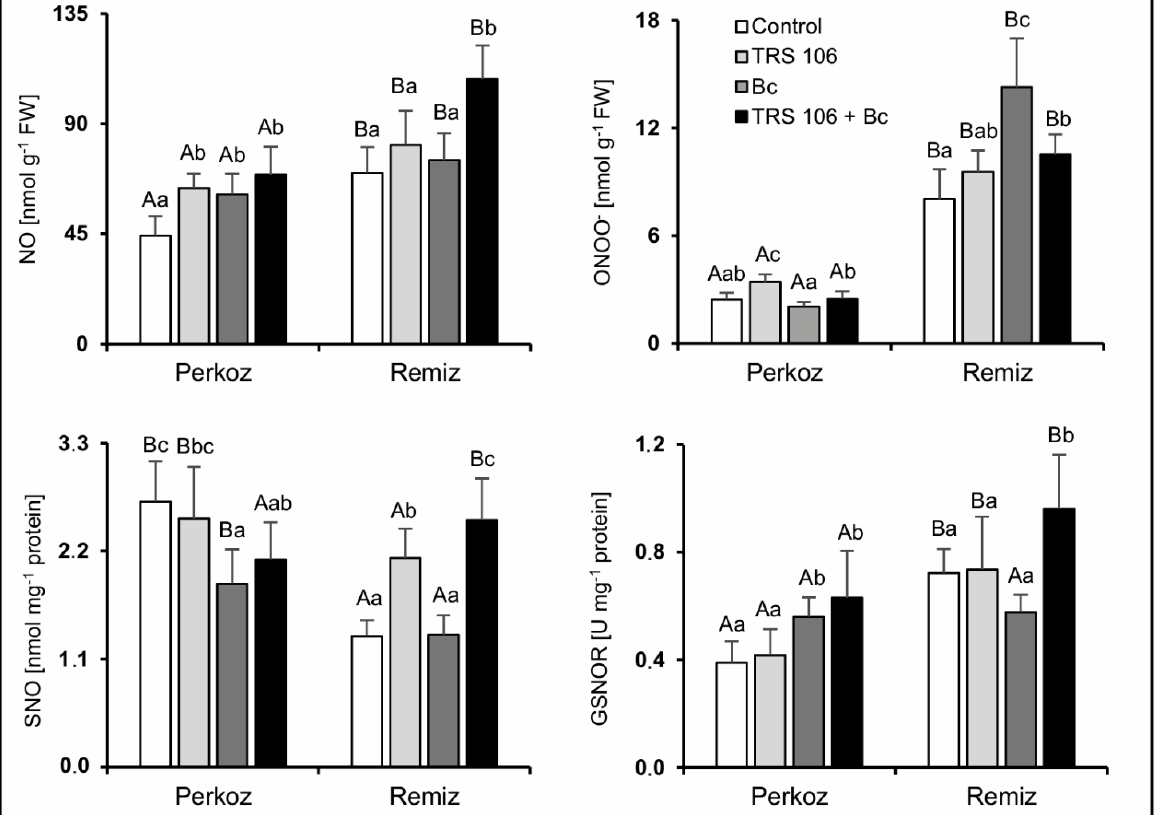
Figure 4. Effect of TRS 106 on nitric oxide (NO), peroxynitrite (ONOO − ), and S-nitrosothiols (SNO) content, and S-nitrosoglutathione reductase (GSNOR) activity in tomato plants. Values represent the means + SE from four independent experiments with three replicates each (n = 12). Separately for each parameter, differences between varieties within a given variant were analyzed with Student’s t -test and marked using letters A and B. Separately for each variety, differences between all variants were analyzed with one-way ANOVA ( p < 0.05) with a Tukey multiple range post hoc test. Data points followed by a different letter are significantly different at p ≤ 0.05. Abbreviations are as in Figure 1.